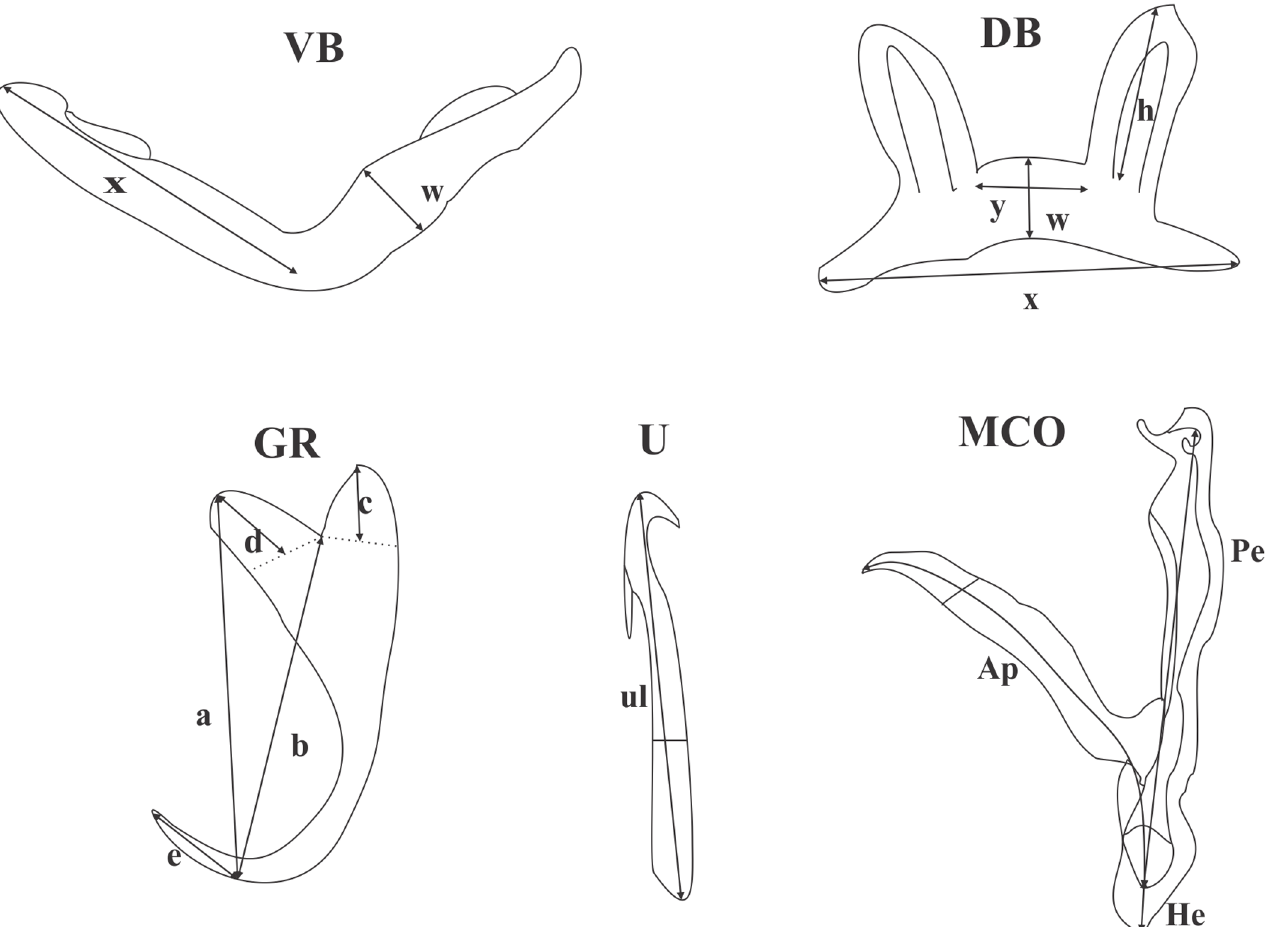
Figure 1. Measurements used in this study. Abbreviations: VB ventral transverse bar: x length of one ventral bar branch, w ventral bar maximum width; DB dorsal transverse bar: h length of auricle, x total length, y distance between auricles, w maximum width; GR gripus: a total length of gripus, b blade length, c outer root length, d inner root length, e point length; MCO male copulatory organ: Ap accessory piece length, Pe penis total length, He heel length; U uncinulus: ul uncinulus